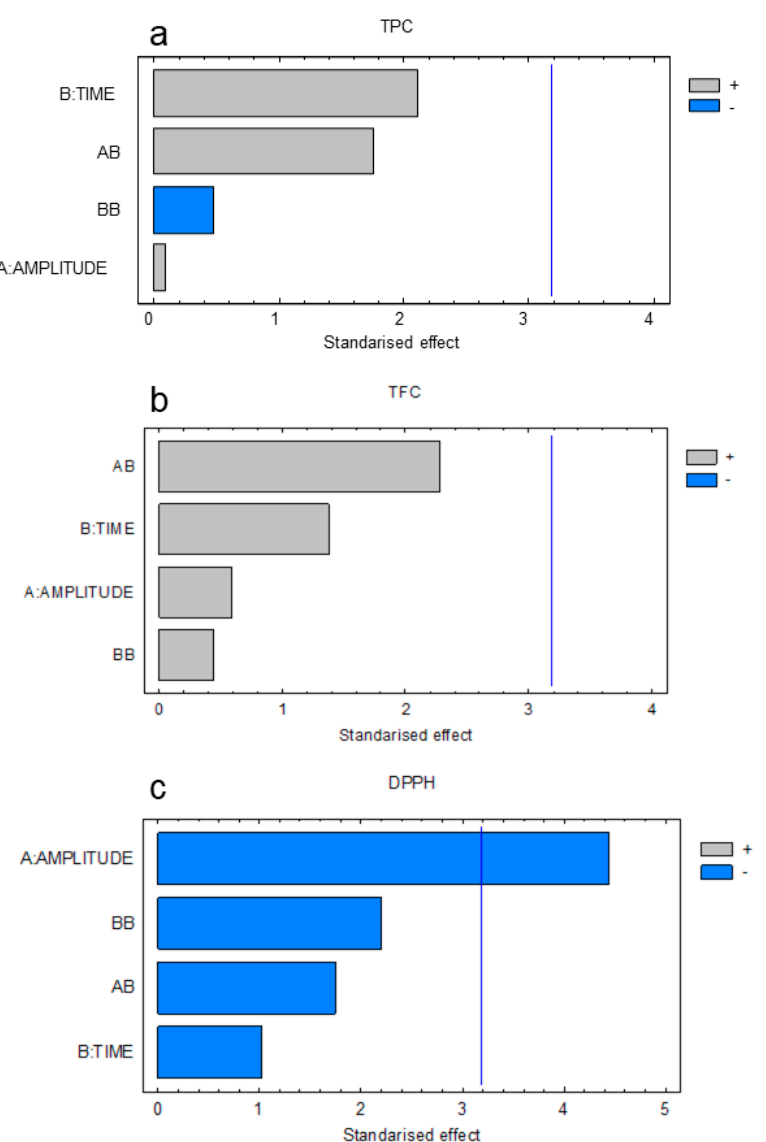
Figure 1. Standardized Pareto diagram of the screening for ( a ) TPC, ( b ) TFC, and ( c ) DPPH.